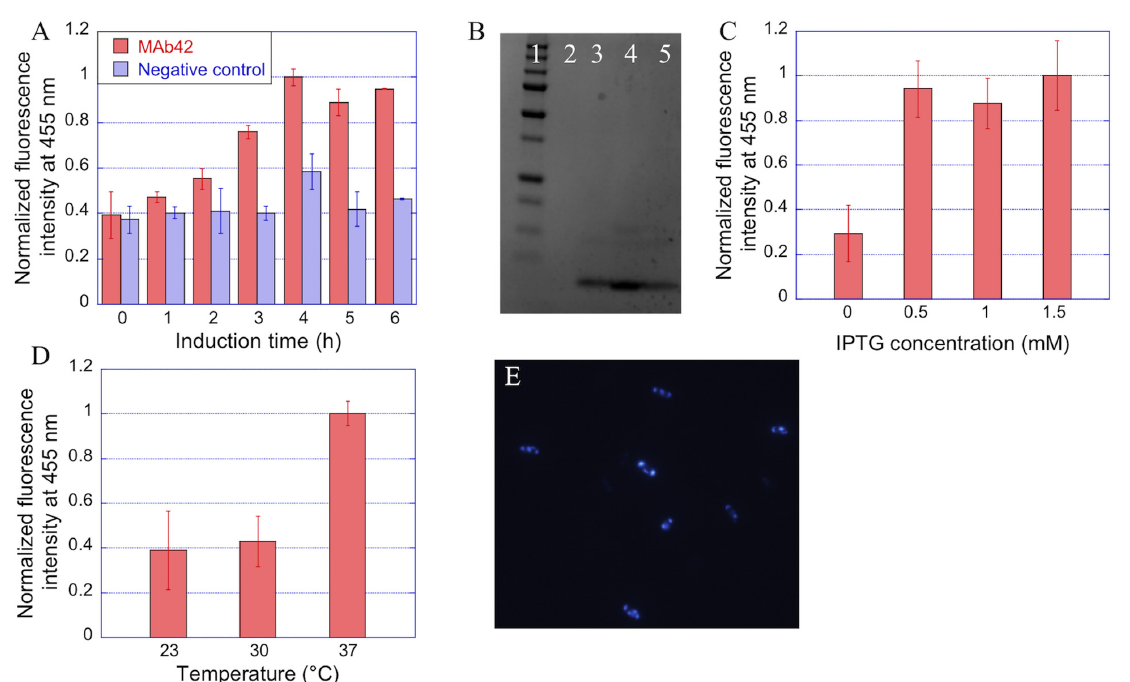
Fig 1. MA β 1 – 42 expression monitoring using Thioflavin-S. A . Variations of normalized fluorescence of Th-S-treated E . coli cells expressing MA β 1 – 42 with culture induction time. B . SDS-PAGE of inclusion bodies formed during E . coli cultures expressing MA β 1 – – 250 kDa protein ladder, lane 2 to 5: samples taken at 0, 2, 4, and 6 hours of growth, respectively. C. Normalized 42 ; lane 1: 10 fluorescence intensity of Th-S-treated E . coli cells expressing MA β 1 – 42 as a function of IPTG concentration used for induction. D . Normalized fluorescence intensity of Th-S-treated E . coli cells expressing MA β 1 – 42 during 4h at various temperatures. E . Fluorescence microscopy of E . coli cells expressing MA β 1 – 42 as IBs after 4 h culture.